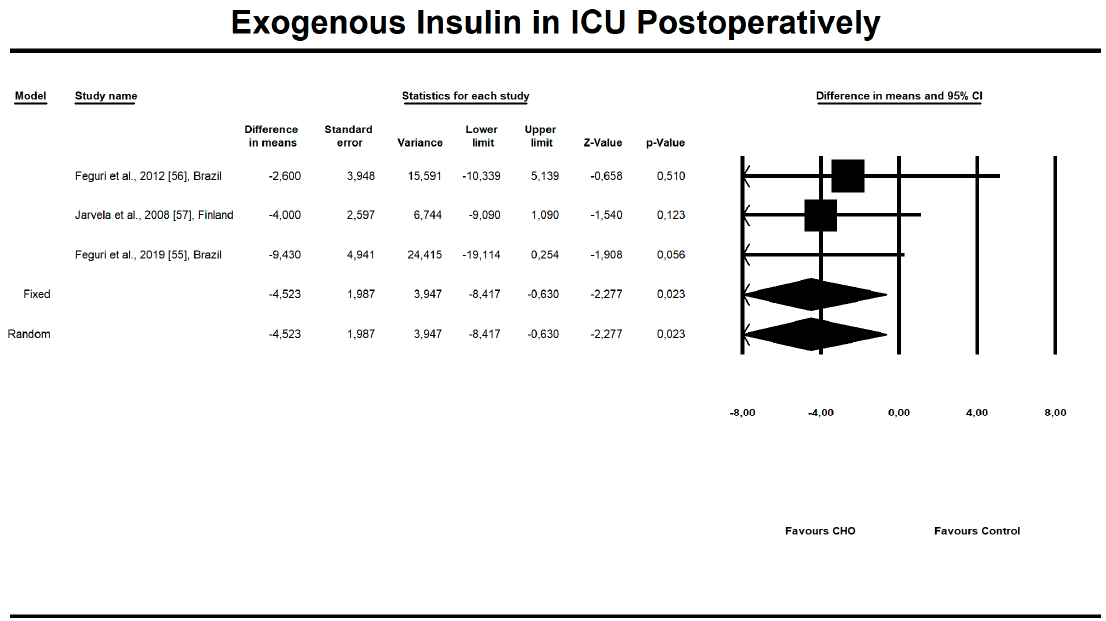
Figure 7. An effect size, difference in means, for exogenous insulin units (IU) in intensive care unit (ICU) postoperatively in patients taking oral carbohydrates (OCH) drinks vs. controls. 95%Cl—95% confidence interval.